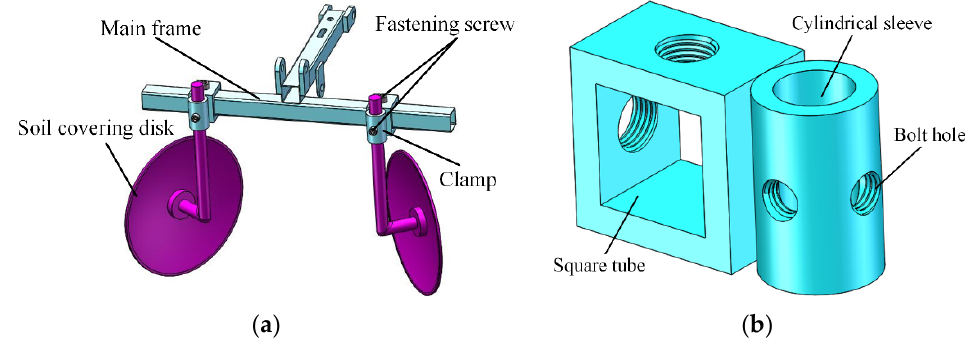
Figure 4. ( a ) The soil-covering part. ( b ) Clamp.